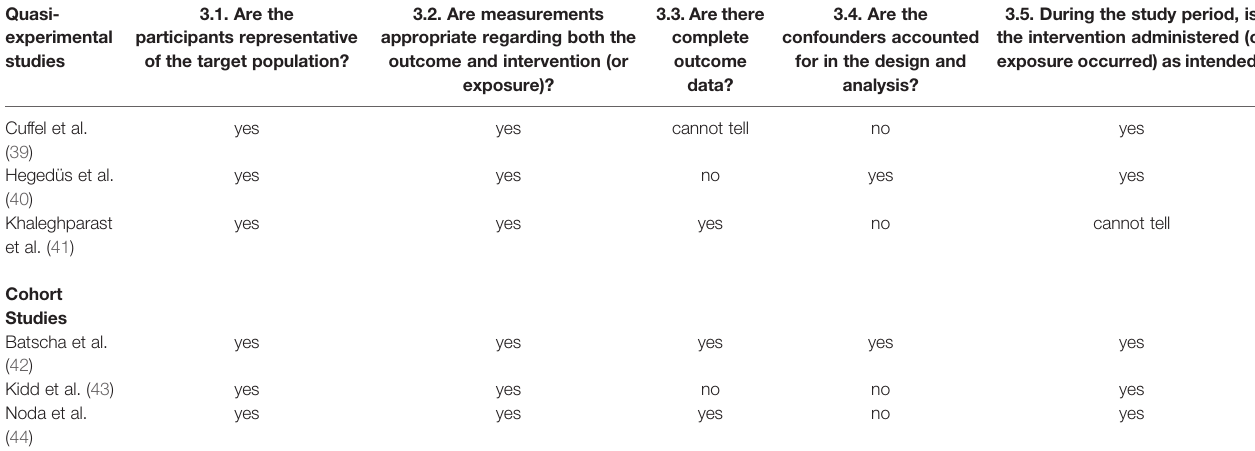
TABLE 3 | Quality assessment of nonrandomized studies using the Mixed Methods Appraisal Tool